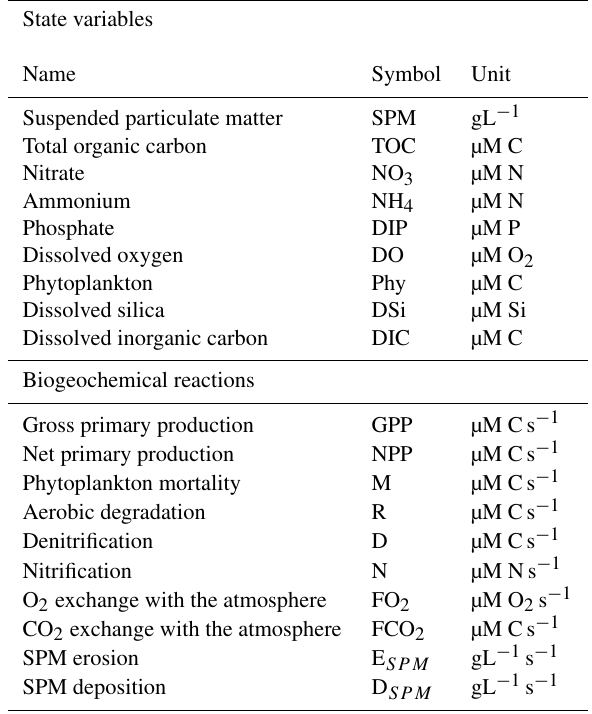
Table 3. State variables and processes explicitly implemented in